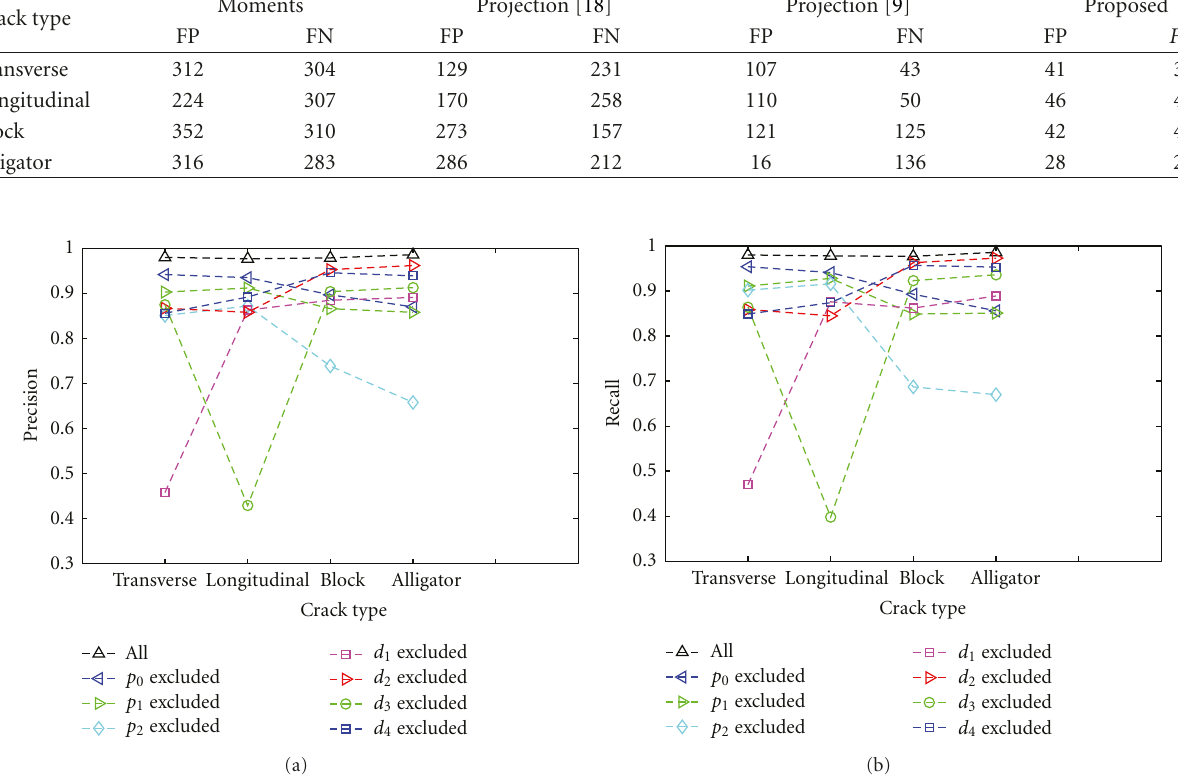
Figure 13: Performance evaluation for the cross-validation processes . (a) Comparison on the Precision, (b) comparison on the